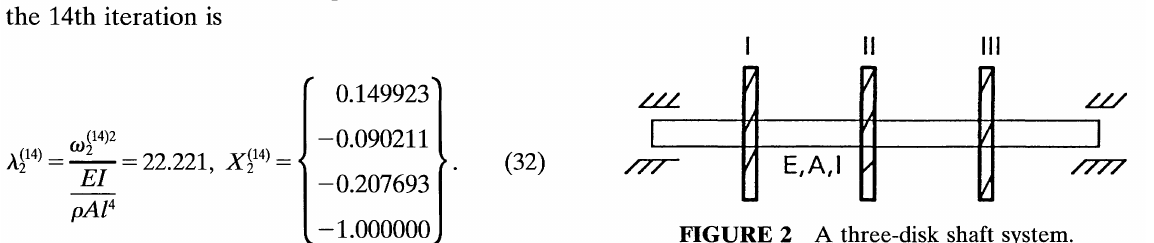
FIGURE 2 A three-disk shaft